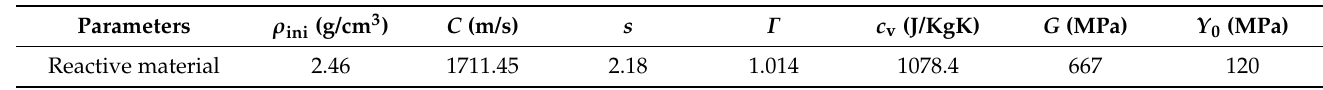
Table 2. Reactive material model